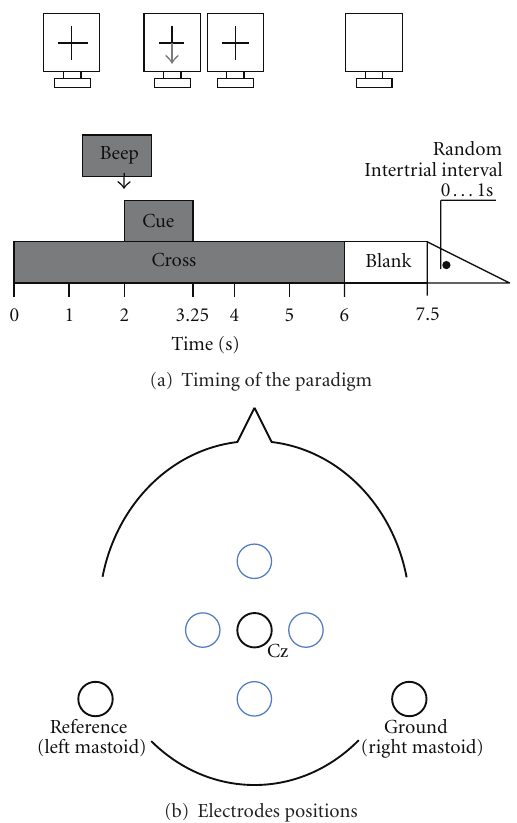
Figure 1: Paradigm and electrodes positions. (a) Foot movement timing scheme of each trial, (b) electrodes position (Cz as a Laplacian